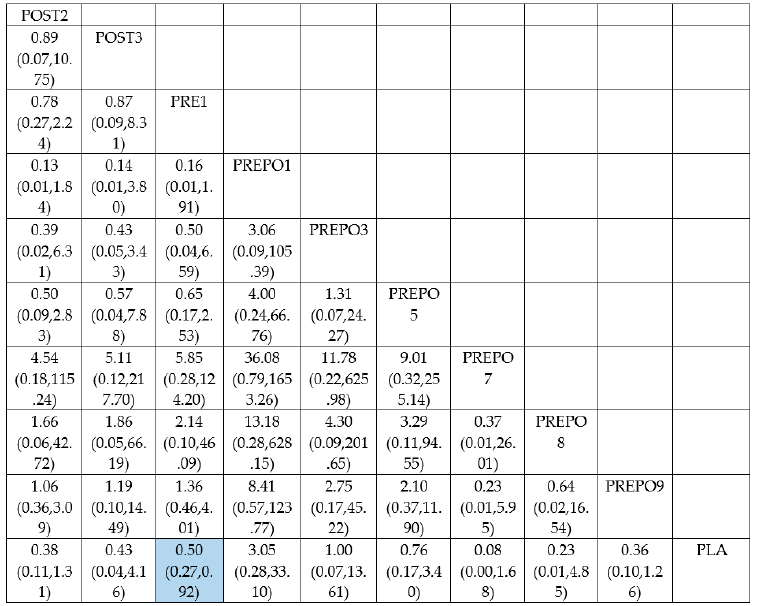
Table 3. Results of network meta-analysis: implant failure (per implant).